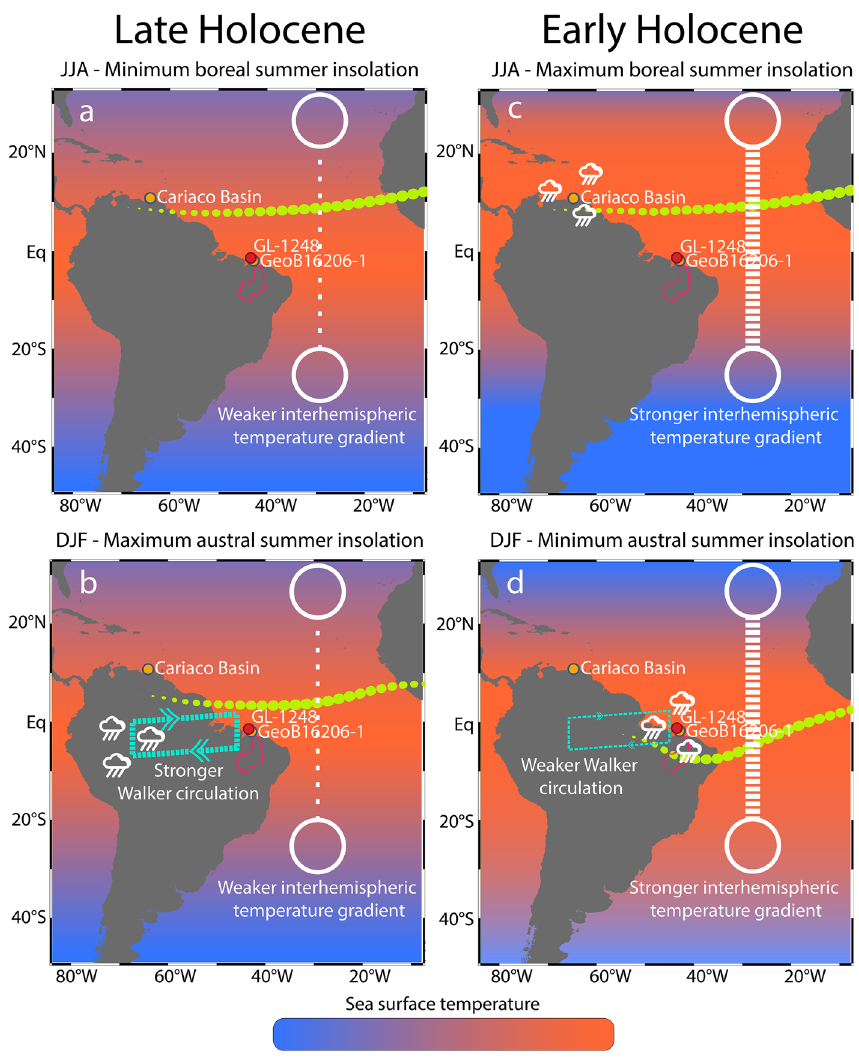
Figure 4. Schematic representation of the main climatological features and mechanism discussed herein. Herein, interhemispheric surface temperature gradient is represented by the difference between Northern Hemisphere (NH) surface temperature and Southern Hemisphere (SH) surface temperature (i.e. NH minus SH surface temperature). This temperature gradient is a result of the combination between insolation forcing and thermal inertia of both hemispheres. Since the SH has higher thermal inertia than NH, the SH thermal response to changes in insolation is slower than the NH. ( a , b ) represent periods of minimum boreal summer insolation (June, July and August—JJA) and maximum austral summer insolation (December, January and February—DJF), respectively, for the late Holocene. Late Holocene boreal and austral summers are marked by weak interhemispheric surface temperature gradient (represented by the white open circle connected through a dashed white arrow). It occurred because minimum insolation during boreal summer ( a ) makes the NH slight warmer than SH in JJA and maximum insolation during boreal winter ( b ) makes the NH slight colder than the SH during DJF. Because of the weak gradient, the ITCZ (neon green dotted band) migration to the north in JJA ( a ) and to the south in DJF ( b ) were not pronounced (i.e. contraction of the meridional range of the ITCZ). Additionally, periods of maximum austral summer insolation ( b ) were marked by stronger regional Walker circulation ascending and descending branches (dashed light green cell). Thus, contraction of the meridional range of the ITCZ and stronger regional Walker circulation resulted in drier conditions over northern NE Brazil (NEB) and northernmost South America (Cariaco Basin) and wetter conditions over the W Amazonia. ( c , d ) represent periods of maximum boreal summer insolation (JJA) and minimum austral summer insolation (DJF), respectively, for the early Holocene. Early Holocene boreal and austral summers are marked by strong interhemispheric surface temperature gradient (represented by the white open circle connected through a dashed white arrow). It occurred because maximum insolation during boreal summer ( c ) makes the NH strongly warmer than SH in JJA and minimum insolation during boreal winter ( d ) makes the NH strongly colder than the SH during DJF. Because of the strong gradient, the ITCZ (neon green dotted band) migration to the north in JJA ( c ) and to the south in DJF ( d ) was very pronounced (i.e. expansion of the meridional range of the ITCZ). Additionally, periods of minimum austral summer insolation ( d ) were marked by weaker regional Walker circulation ascending and descending branches (dashed light green cell). Thus, expansion of the meridional range of the ITCZ and weaker regional Walker circulation resulted in wetter conditions over NEB and northernmost South America (Cariaco Basin) and drier conditions over the W